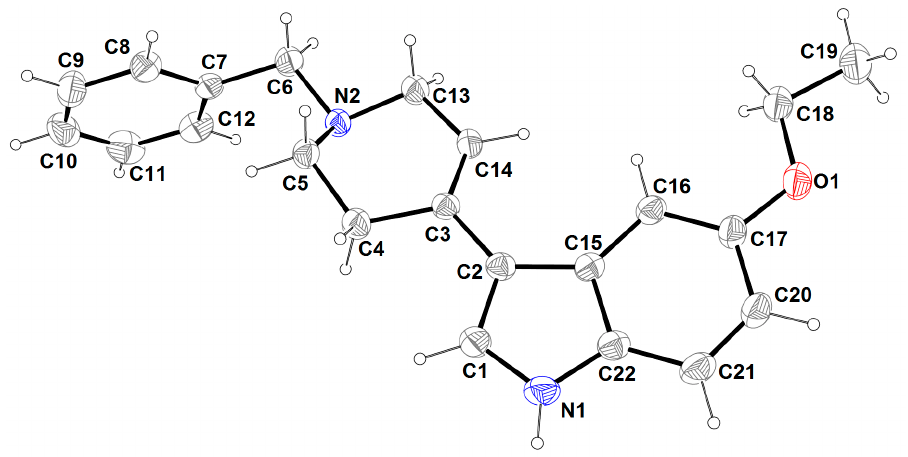
Figure 3. Molecular structures with atom numbering scheme of D2AAK1_3. Displacement ellipsoids are shown at the 30% probability level. Table 1. Crystal data and structure refinement of D2AAK1_3.